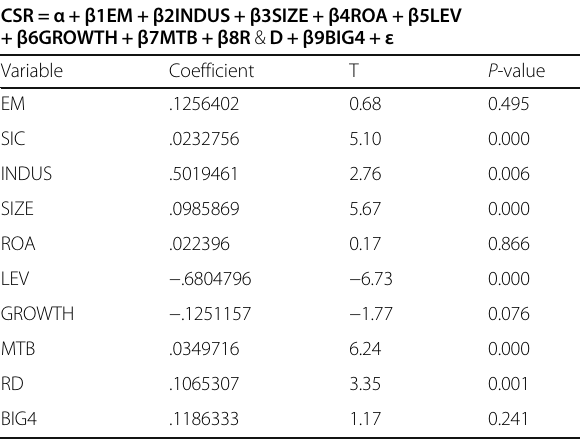
Table 9 Robustness check for Model II (CSR)